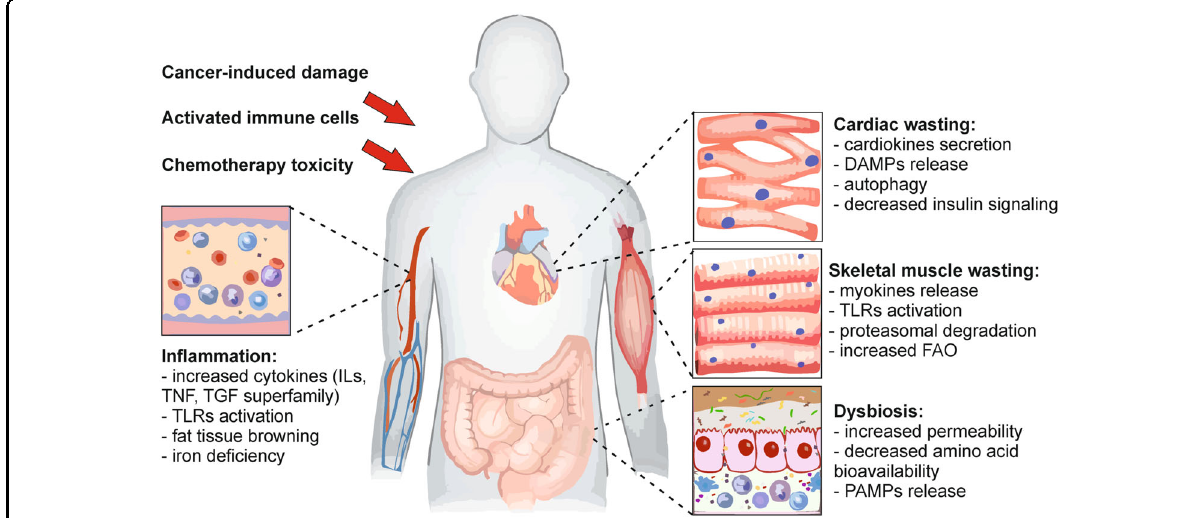
Fig. 1 Multi-organ alterations in cancer-induced cachexia. Cancer cells, together with the activation of the in fl ammatory response and the toxic effects of chemotherapy, contribute to concomitant and interconnected alterations in multiple distant organs, including the cardiac and skeletal muscles and the gut, in the course of cancer-induced cachexia. ILs interleukins, TNF tumor necrosis factor, TGF transforming growth factor, TLRs toll- like receptors, DAMPs damage-associated molecular patterns, FAO fatty acid oxidation, PAMPs pathogen-associated molecular